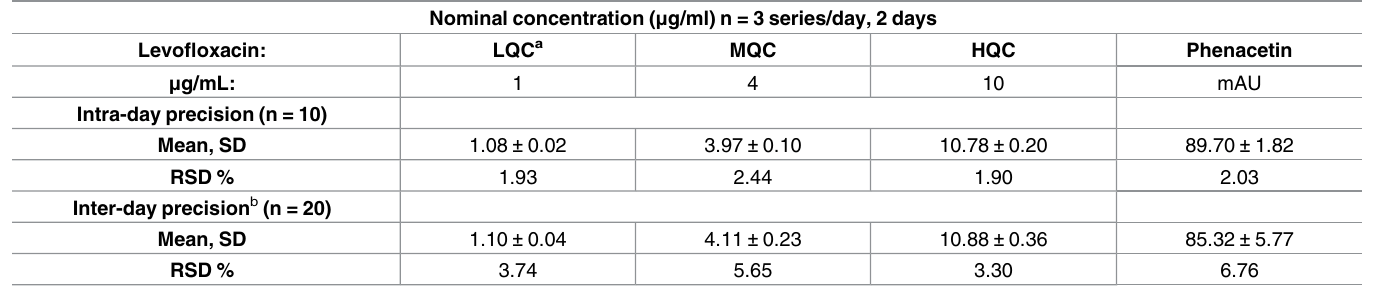
Table 1. Inter-assay variability of calibration curve, Intra-day precision and Inter-day precision.